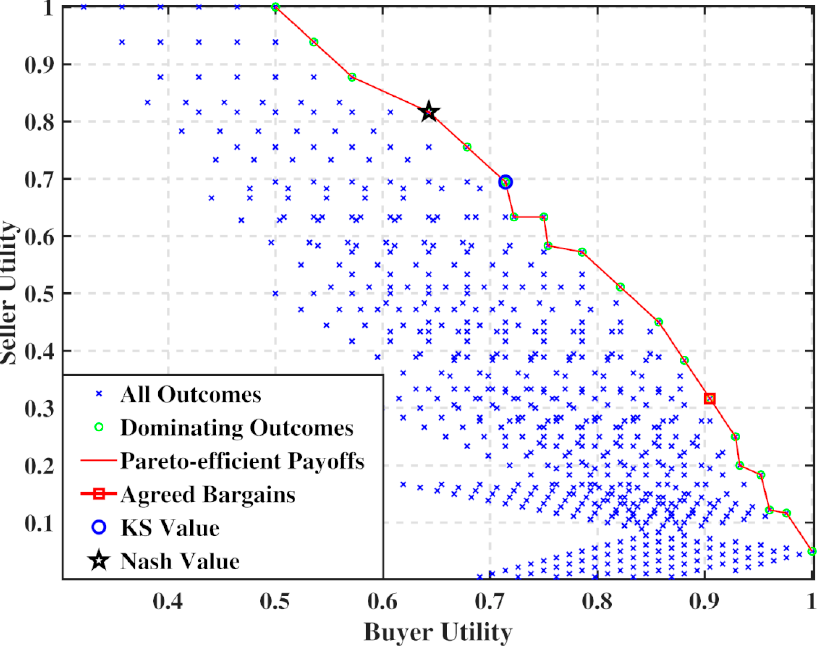
Figure 3. Automated negotiation possible outcomes space for seller and buyer 1 expert agents.